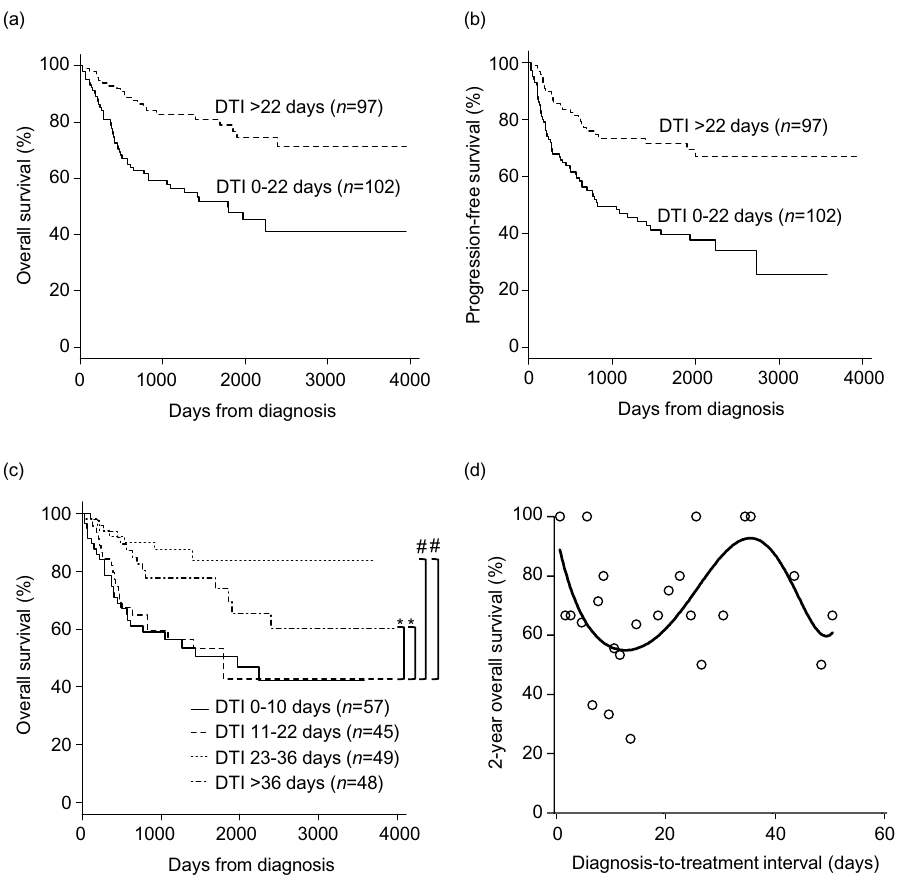
Figure 2. Survival of patients. Kaplan–Meier curves of overall survival (OS) ( a ) and progression-free survival ( b ) by diagnosis-to-treatment interval (DTI) divided into two groups. ( c ) Kaplan–Meier curves of OS by DTI divided into quartile. *p < 0.001; # p < 0.05. ( d ) Two-year OS according to DTI. Nonlinear relationship was modeled using polynomial regression.